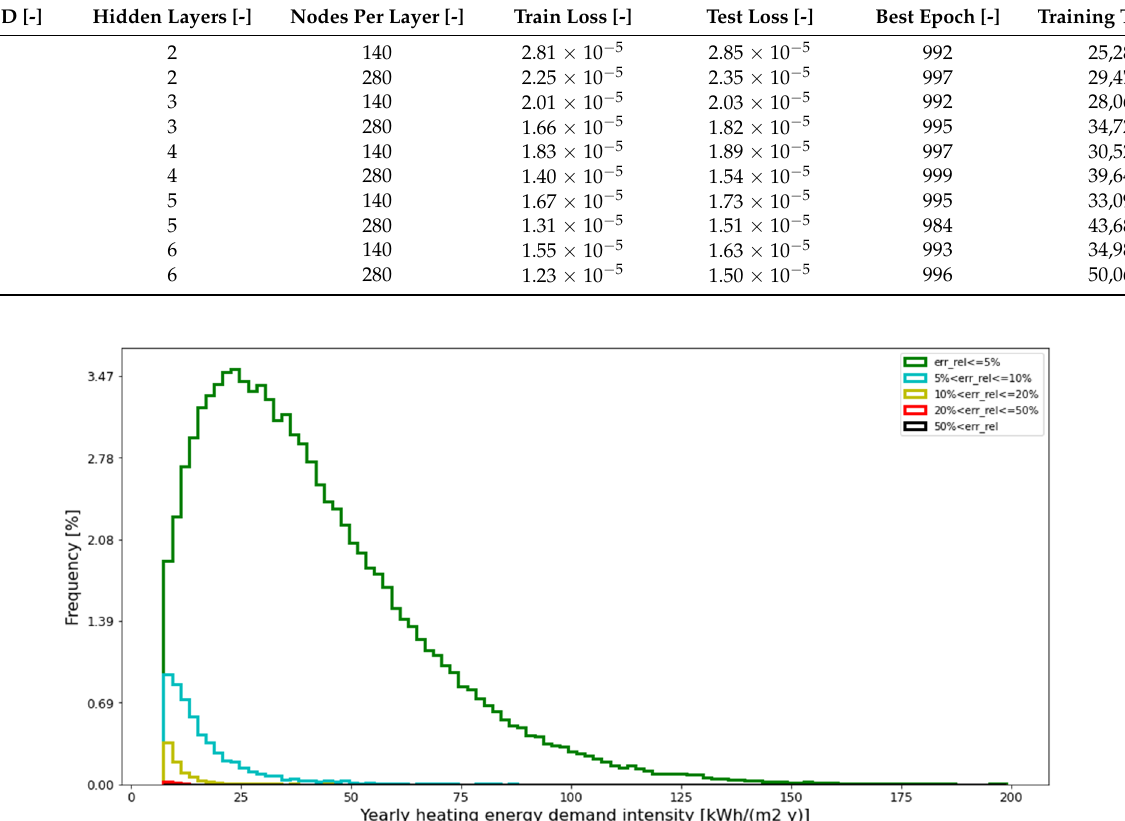
Figure 2. Distribution of occurrence for prediction errors.